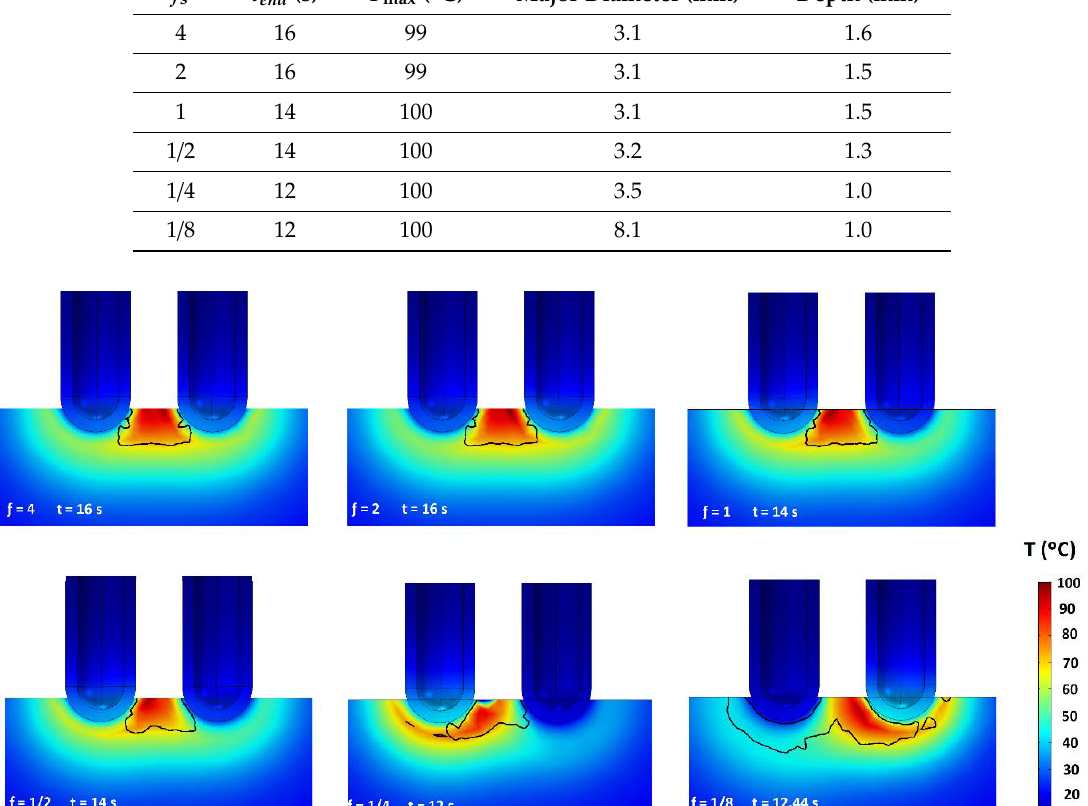
Table 3. Results of the switching monopolar mode using 45 V for different switching frequency ( f S ) values.